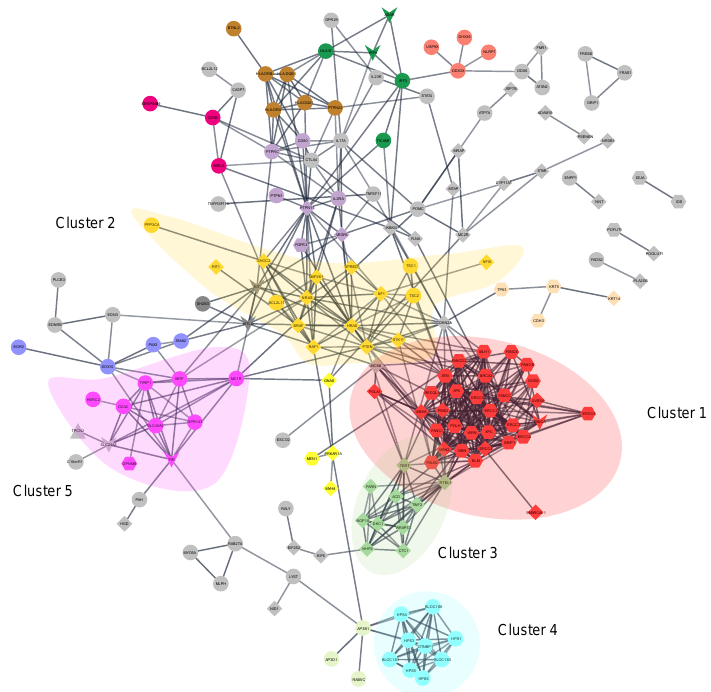
Figure 3. Pigment disorder PPI network and results of clustering analysis. Network among 169 pig- mentation proteins based on the STRING database. Similar colors of proteins correspond to the participation in the same network cluster. The top 5 largest clusters are shaded in circles. The shapes of the proteins report the pigmentation status of the disorder associated with the protein: diamonds are hyperpigmentation, circles are hypopigmentation, hexagons are mixed pigmentation, triangles are pigmentation phenotype, and V-shape are proteins that link to multiple diseases with combined hyper-/hypo or mixed